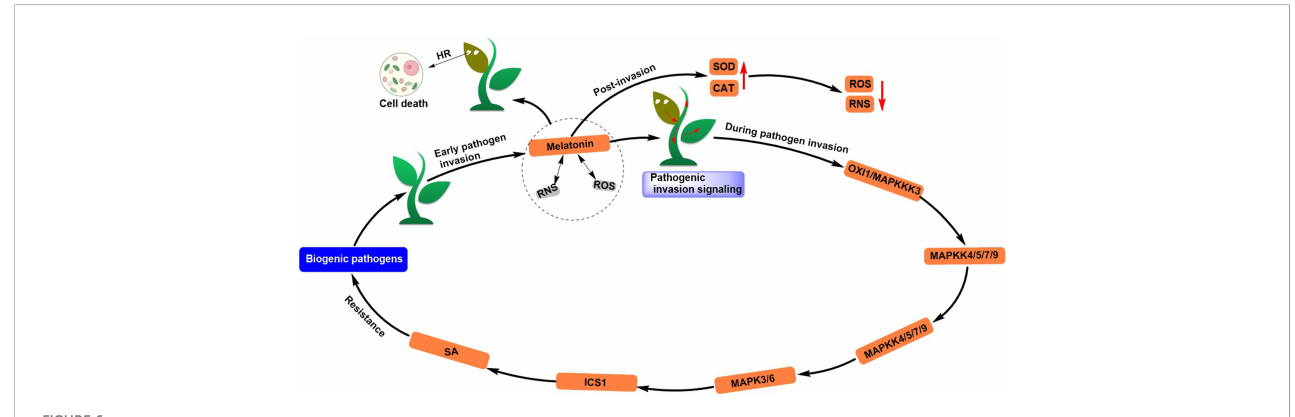
FIGURE 6 Melatonin induces resistance to biotic stress responses in